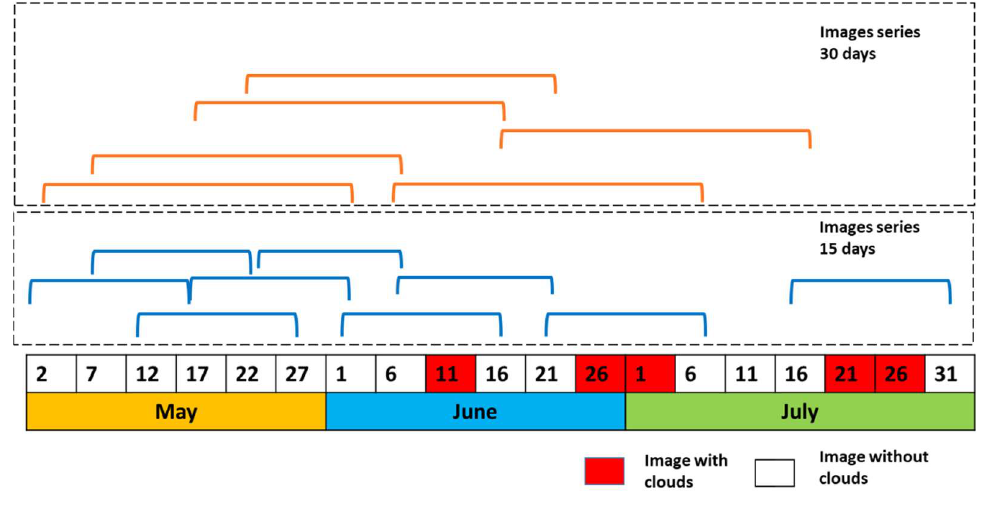
Figure 9 . Images used for combination C2 and C4 for May, June, and July . Figure 9. Images used for combination C2 and C4 for May, June, and